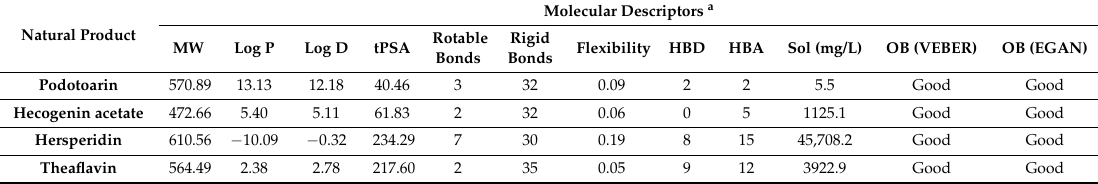
Table 2. ADME/TOX properties of the NPs proposed as inhibitors for HER receptors using FAF-Drugs3.